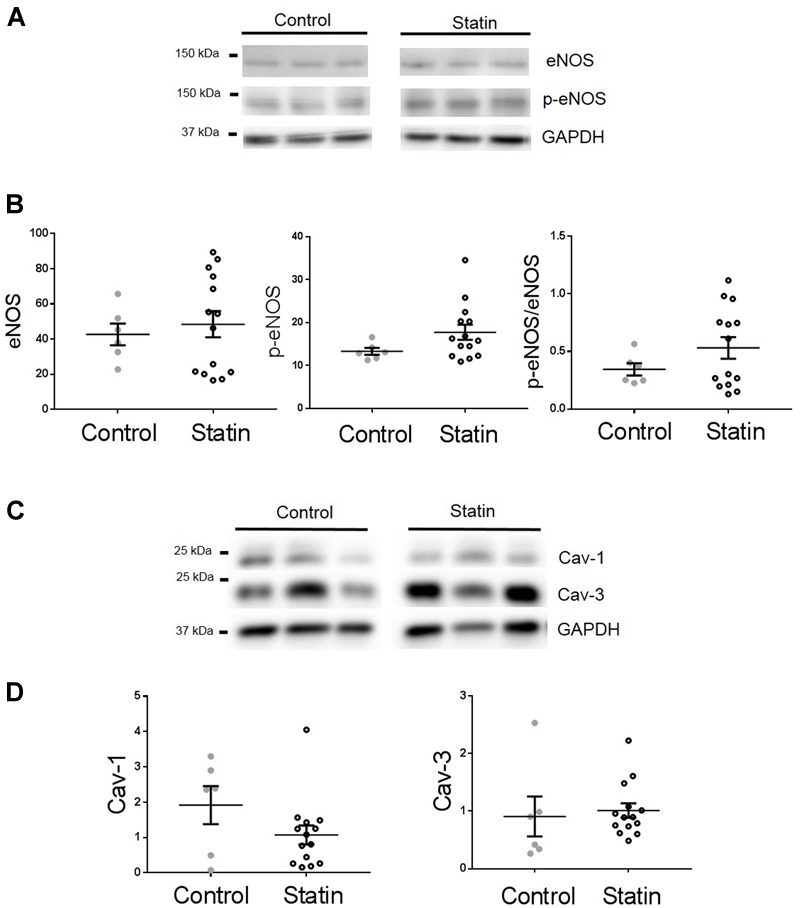
Effect of statin treatment on proteins that regulate NO production in human myocardium. Representative immunoblots from the same gel and scatter plots showing expression of eNOS and Ser1177 phosphorylated eNOS (p-eNOS) (A,B), Cav-1 and Cav-3 (C,D) in atrial muscle from statin-treated male patients (N = 14). Male patients not taking statins formed the control group (N = 6). Plots show mean ± SEM.